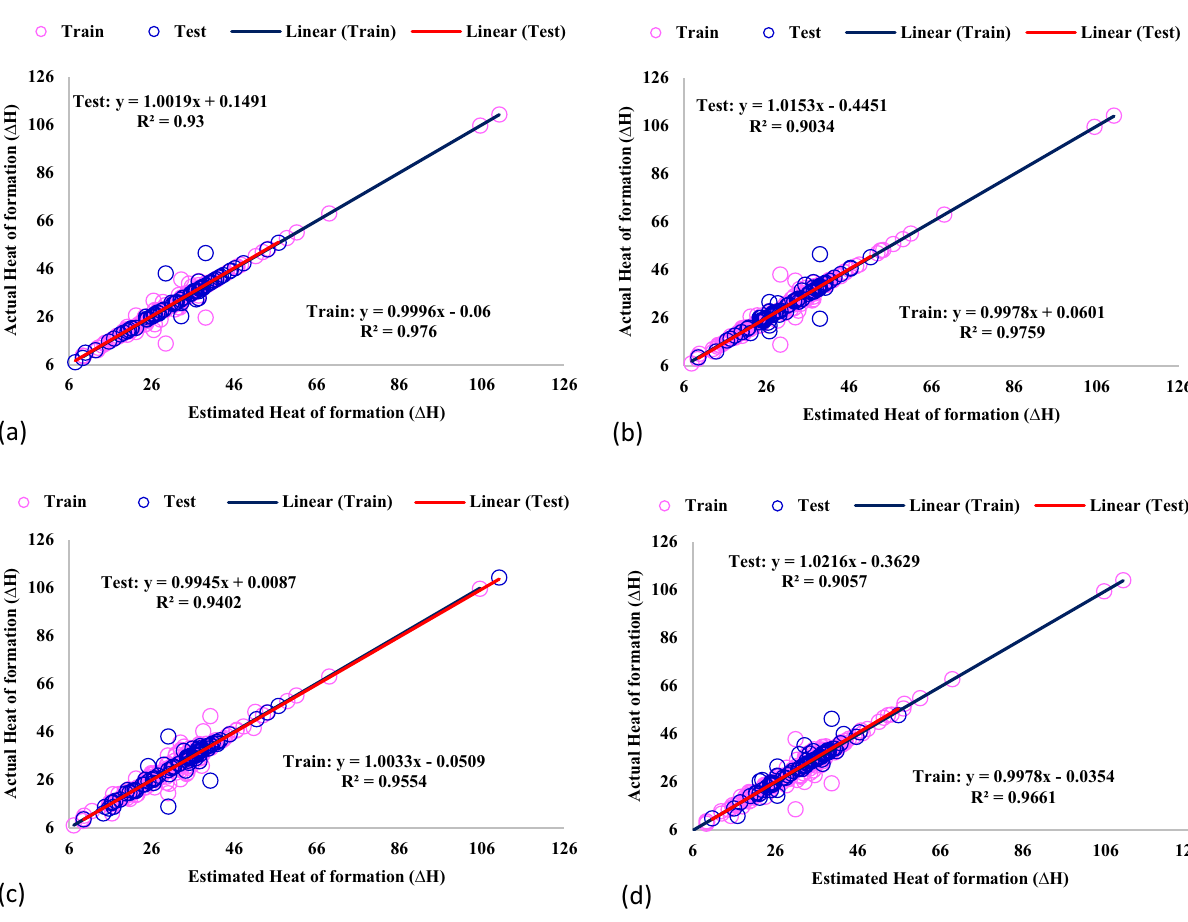
Fig. 5, the data are placed very close to the bisector line, and their respective linear fitting equations are almost the same as the merit line (slope of unit with R 2 greater than 0.9). Thus, the established GPR models could